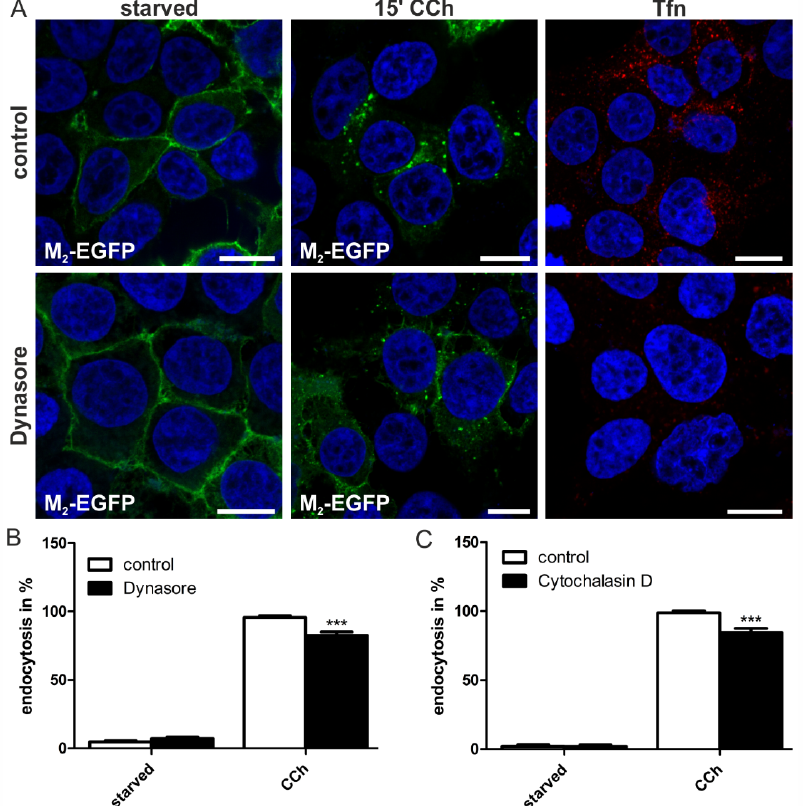
Figure 5. Dynasore moderately reduces CCh-induced M 2 endocytosis. ( A ) HEK 293T cells were transiently transfected with M 2 -EGFP, starved for 18 h in serum-free medium and pretreated with 80 μ M Dynasore or DMSO. Cells were left untreated, stimulated with 1 mM CCh for 15 min or incubated with Alexa Fluor 546-coupled transferrin (Tfn546, red); Cells were fixed, and the nuclei were stained with DAPI (shown in blue). Scale bars: 10 μ m. ( B ) The number of cells displaying M 2 receptor internalization was quantified and is shown as the percentage of cells exhibiting intracellular M 2 . At least 100 cells were counted per condition. Results are shown as the mean ± SD. Statistical analysis was performed with two-way ANOVA: *** p < 0.001; ( C ) Quantification of M 2 -EGFP endocytosis in cytochalasin D treated